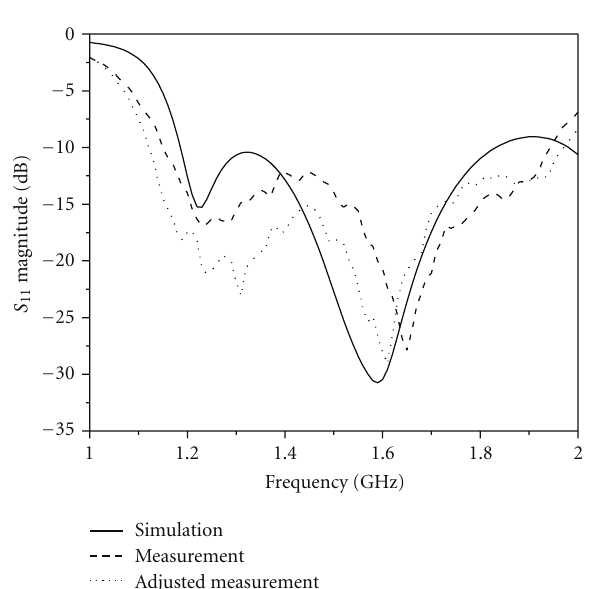
Figure 5: Simulated and measured reflection characteristics versus frequency.